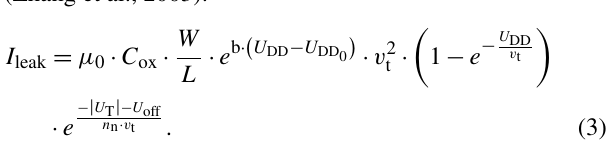
with small surface and a low energy consumption. The pro- cess operates like the common metal oxide semiconduc- tor field-effect transistor (MOSFET), but the use of three- dimensional fin structures (Fig. 2) allows placement of a higher number of single transistors on a same size chip (Han and Wang,